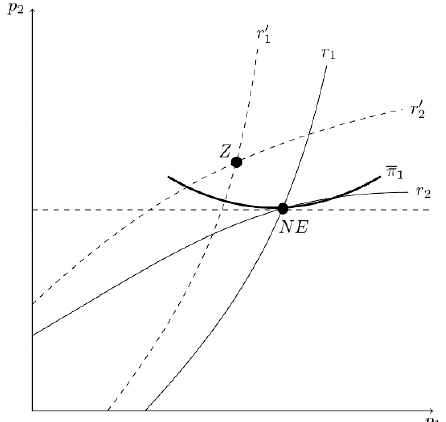
Figure 10. Owner 1’s Incentive to Hire a CEO Who Overestimates Product Substitutability in the Bertrand Model When Overestimation Affects the Best ‐ Reply Curves of Both Firms.